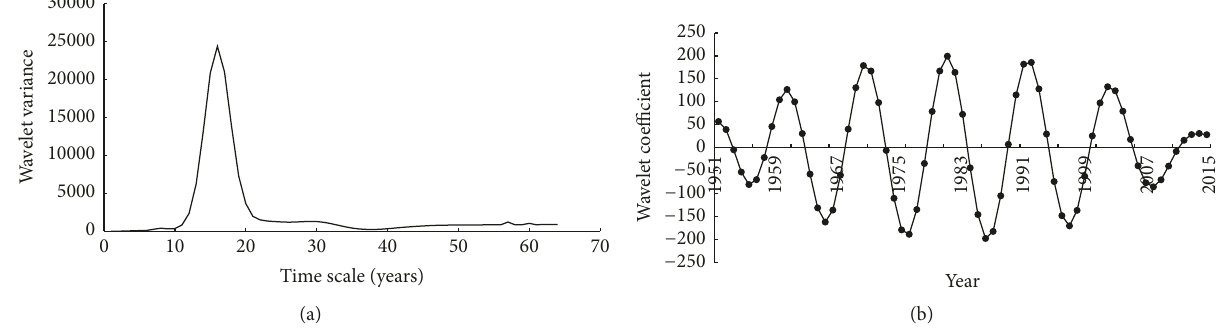
Figure 6: Wavelet variance and real part coefficient changes of sunspot number: (a) wavelet variance of sunspot number; (b) wavelet coefficient changes of sunspot number from 1951 to 2015 on a 16-year